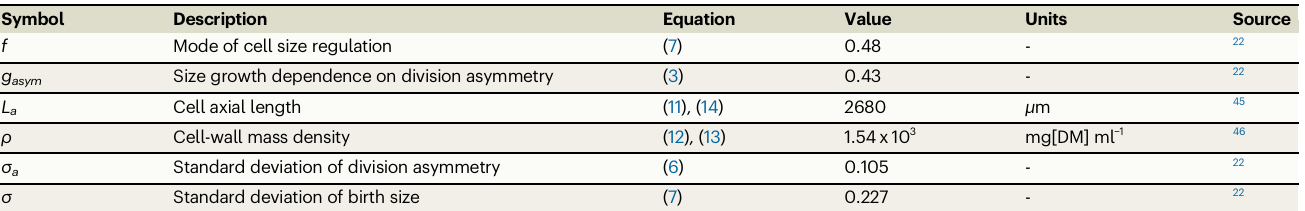
Table 2 | Parameters used in the model that are taken directly from